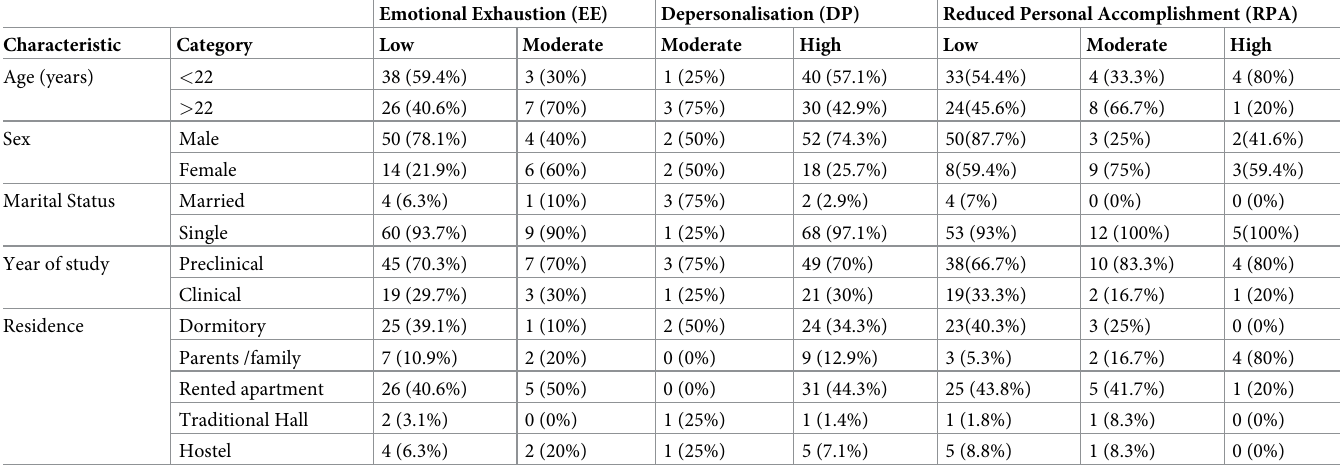
Table 4. Results on demographic characteristics and burnout